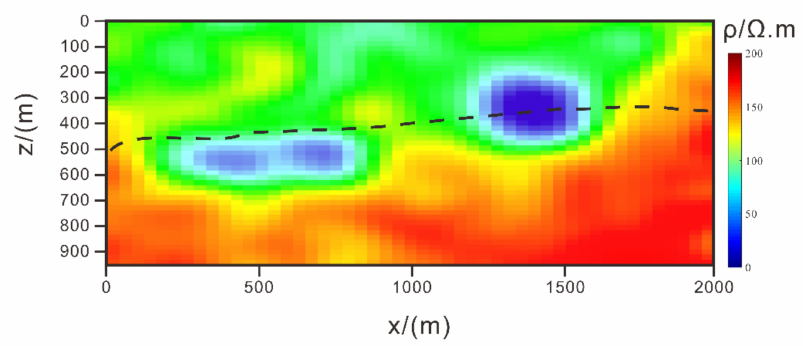
Figure 14. Vertical sectional view of the 3D inversion of the measurement taken on the S300 sur- vey line.